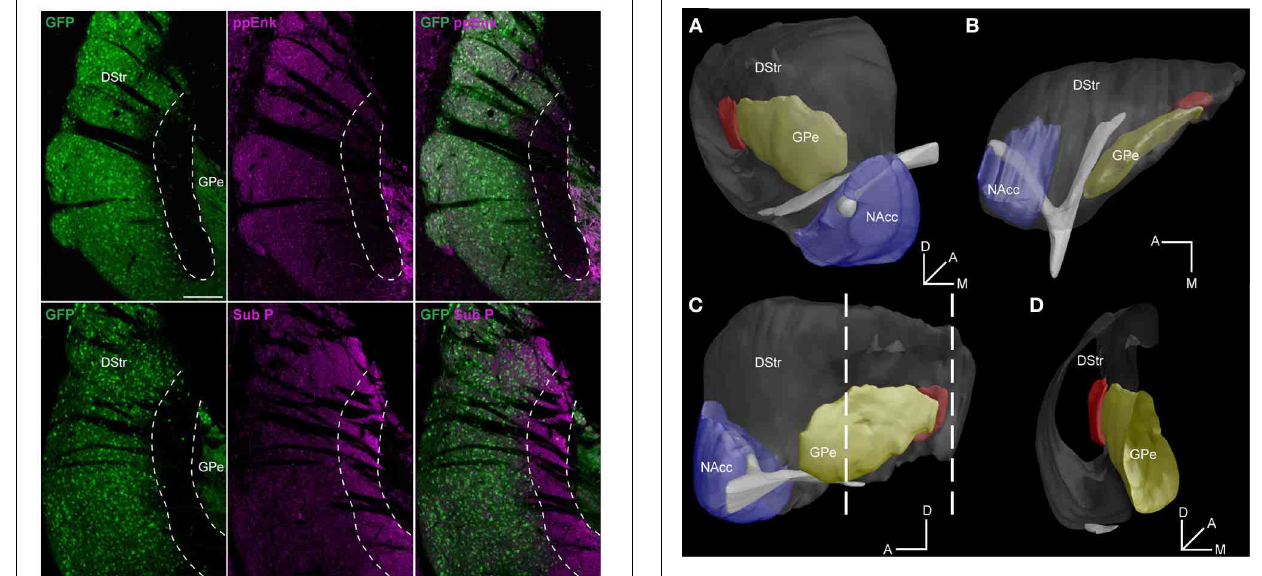
to the caudal part of the dorsal striatum (Ledoux et al., 1991).